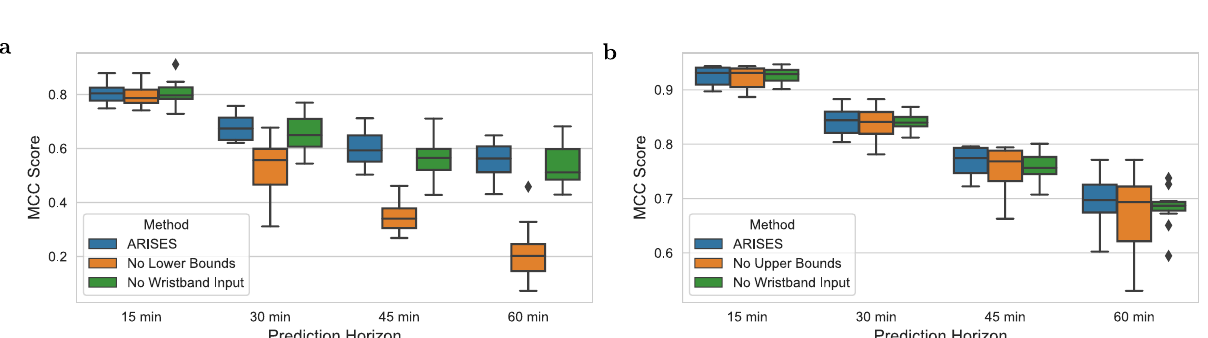
Fig. 4 Ablation analysis on the prediction of adverse glycemic events, evaluated on the 12 T1D subjects. a MCC scores for hypoglycemia prediction. b MCC scores for hyperglycemia prediction. The lower bounds signi fi cantly improved hypoglycemia prediction, while the use of wristband data enhanced MCC scores for all the prediction horizons. The lower and upper hinges of boxplots show the Q1 and the Q3, respectively. The central lines indicate the median, while the whiskers extend to 1.5 IQR.